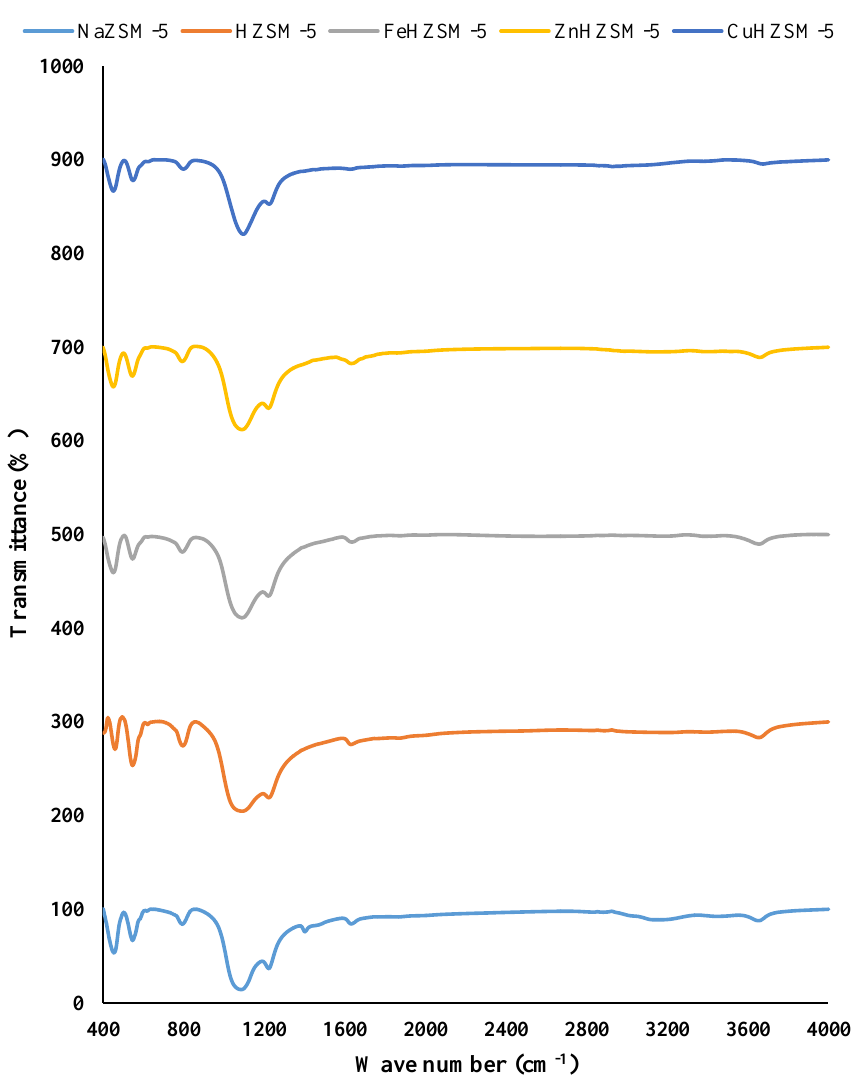
Figure 3. Infrared spectra for NaZSM-5, HZSM-5, 4 wt. % FeHZSM-5, 4 wt. % CuHZSM-5 and 4 wt. % ZnHZSM-5 catalysts.